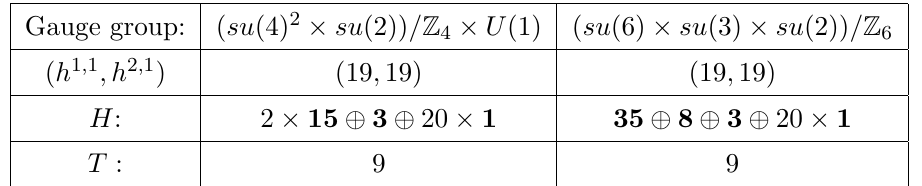
Table 2 . Summary of massless 6D F-theory spectra with Z 4 and Z 6 fundamental group, geomet- rically realized by the Schoen